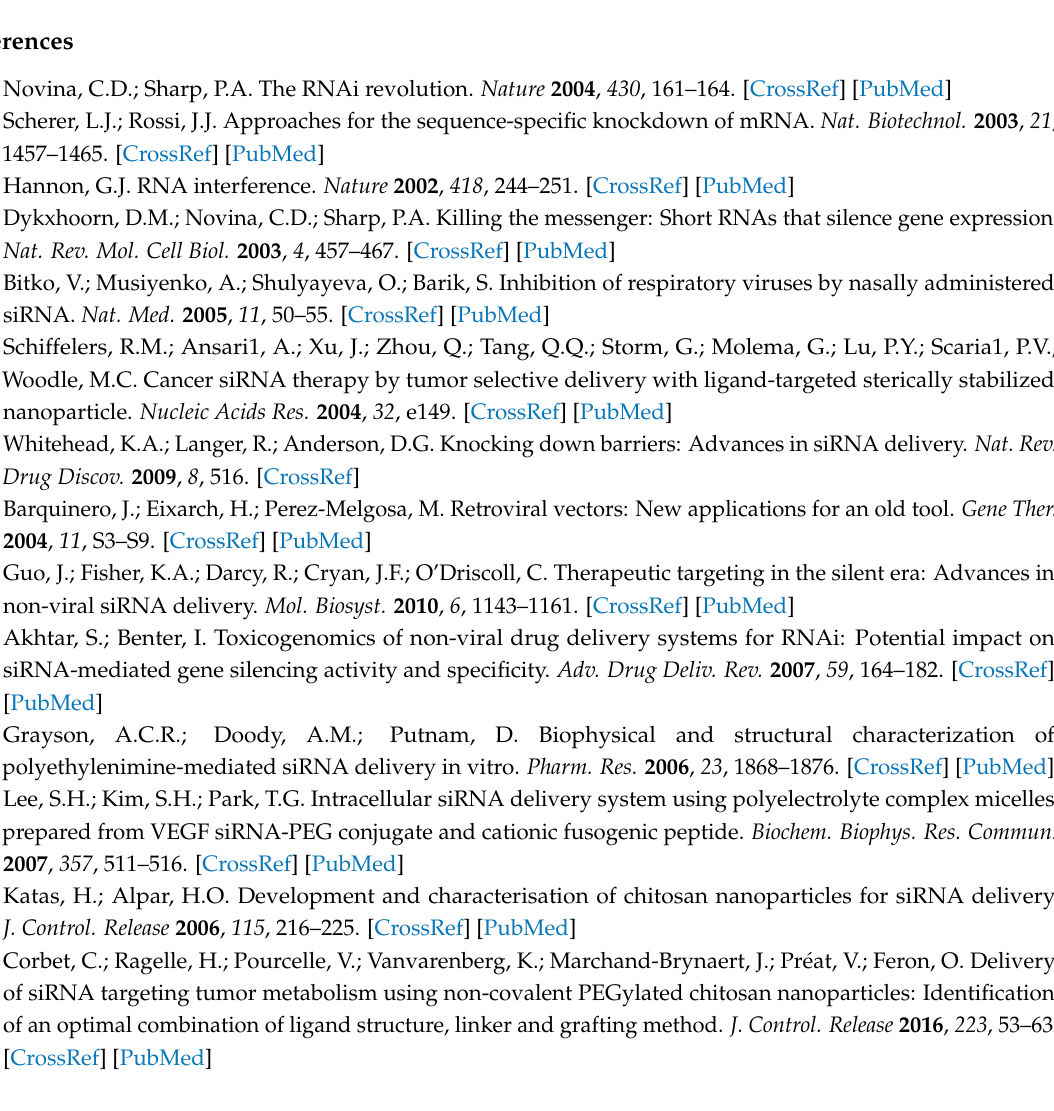
Figure S1: The lipid bilayer membrane before and after an annealing MD simulation [43,44]. Figure S2: The formation of stable siRNA-PMAL complex using an anneal MD simulation. Figure S3: The changes of lipid bilayer membrane during the passive and active transport of siRNA assisted by PMAL. Figure S4: The channel formation of the siRNA delivery assisted by PMAL. Figure S5: The histogram of configurations within the umbrella sampling windows. Figure S6. Flatness of membrane for naked